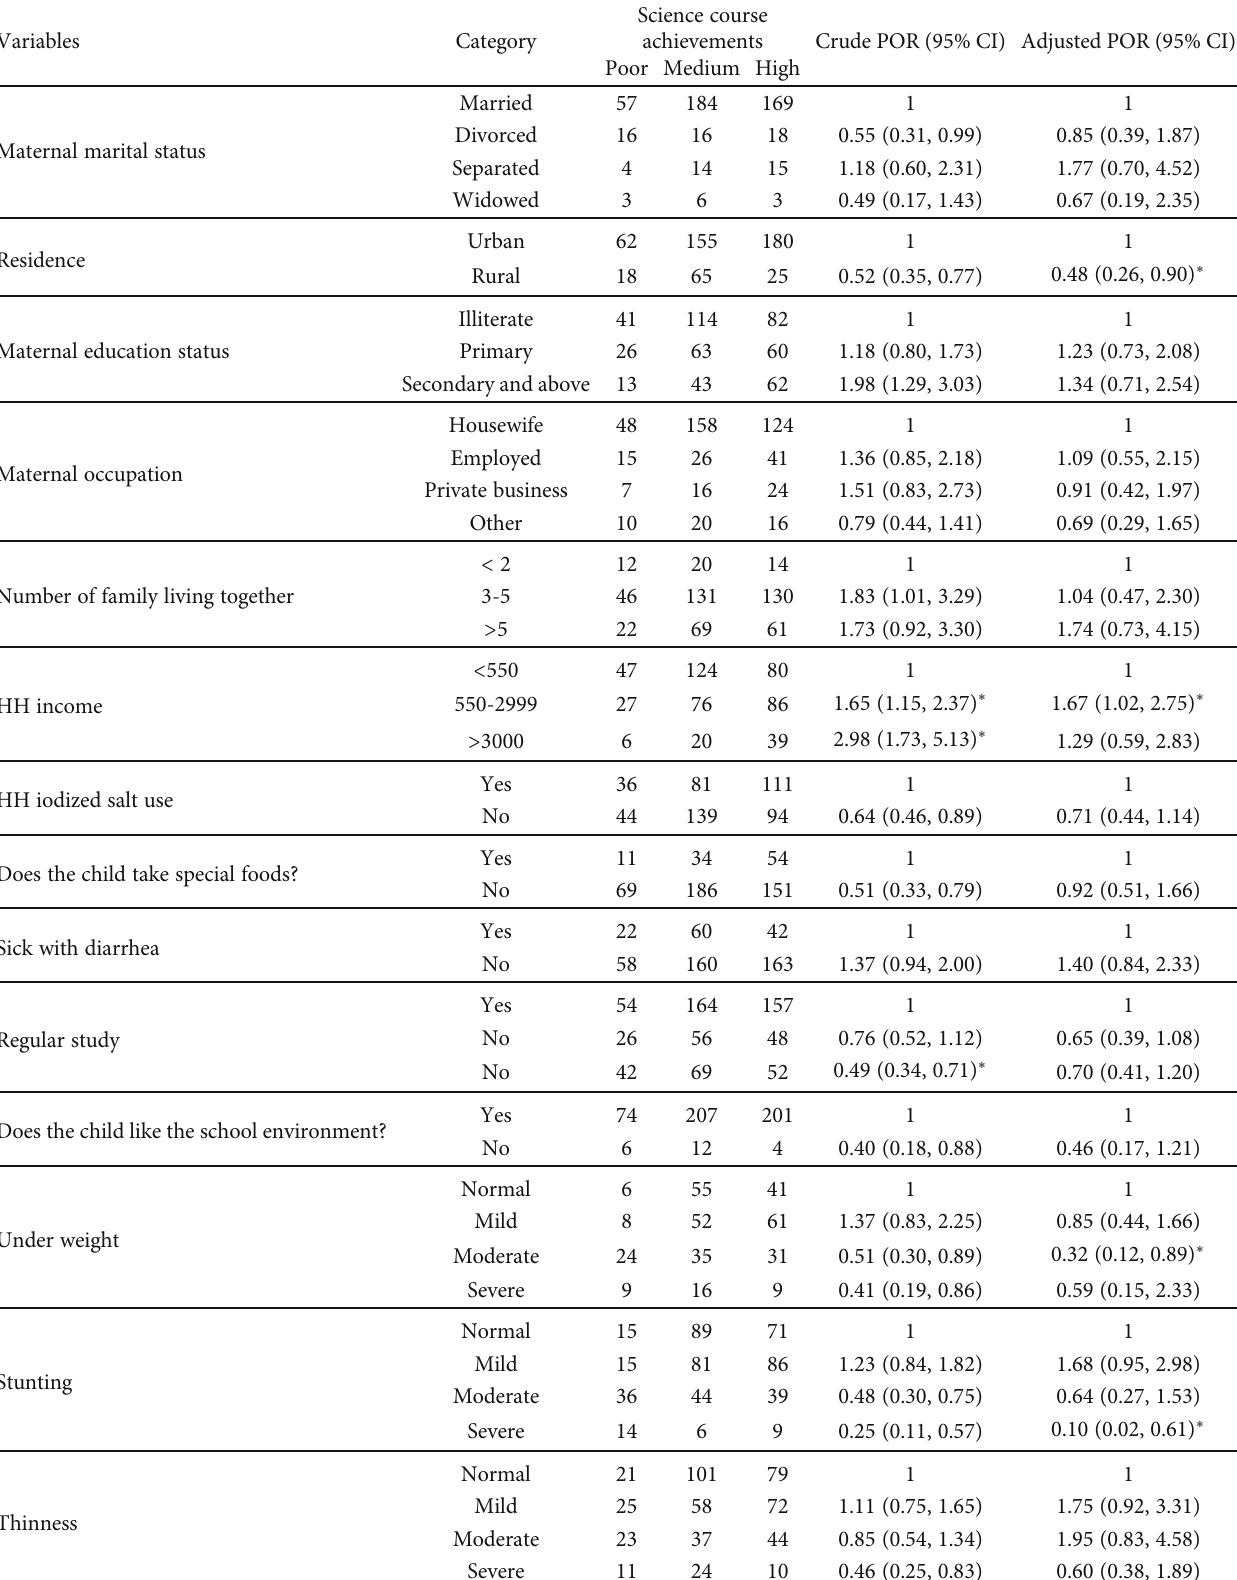
Table 4: Factors associated with Science course achievement among school-aged children in Lalibela town, North